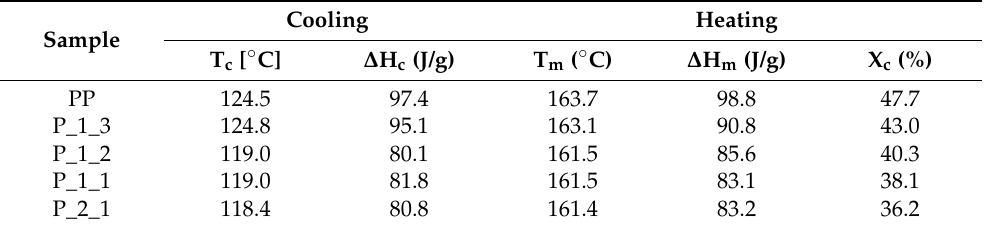
Table 3. The results of the differential scanning calorimetry (DSC) for individual samples.